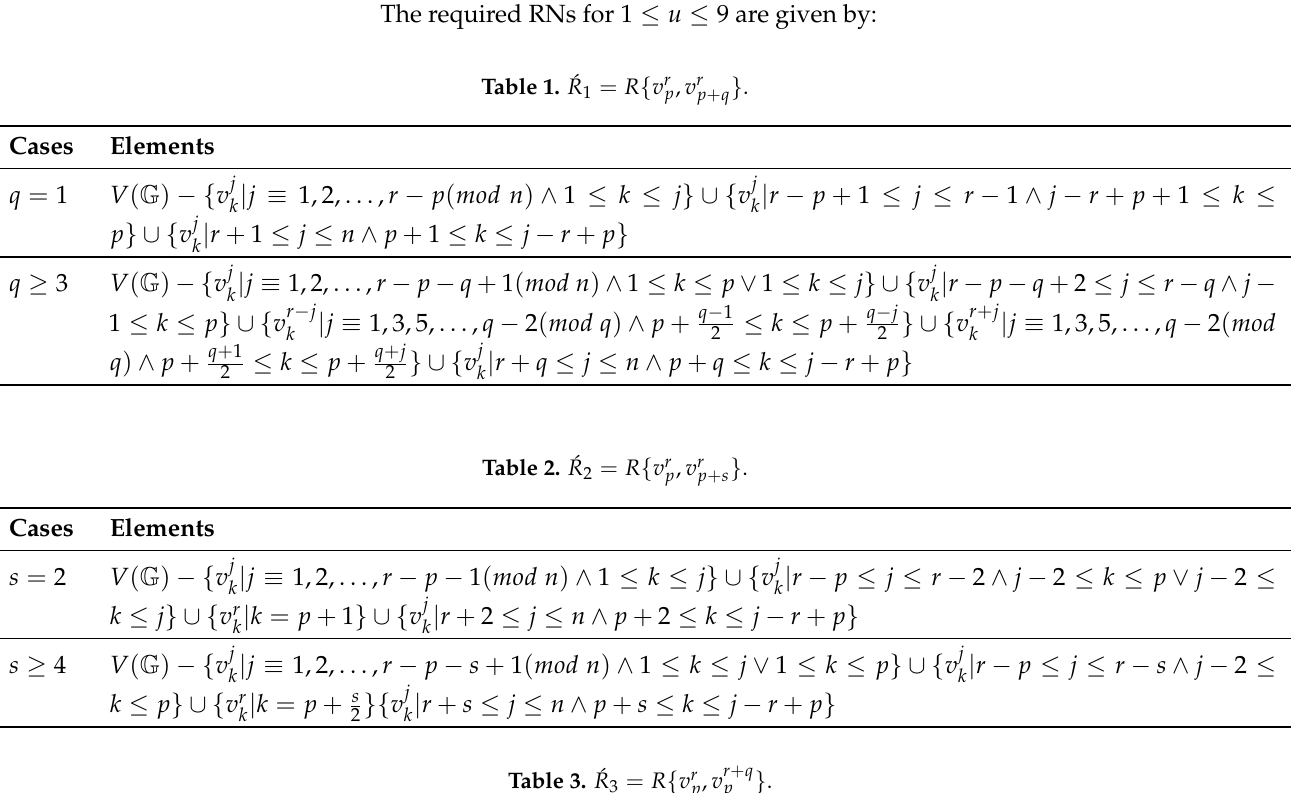
Table 3. ´ R 3 = R { v r p , v r